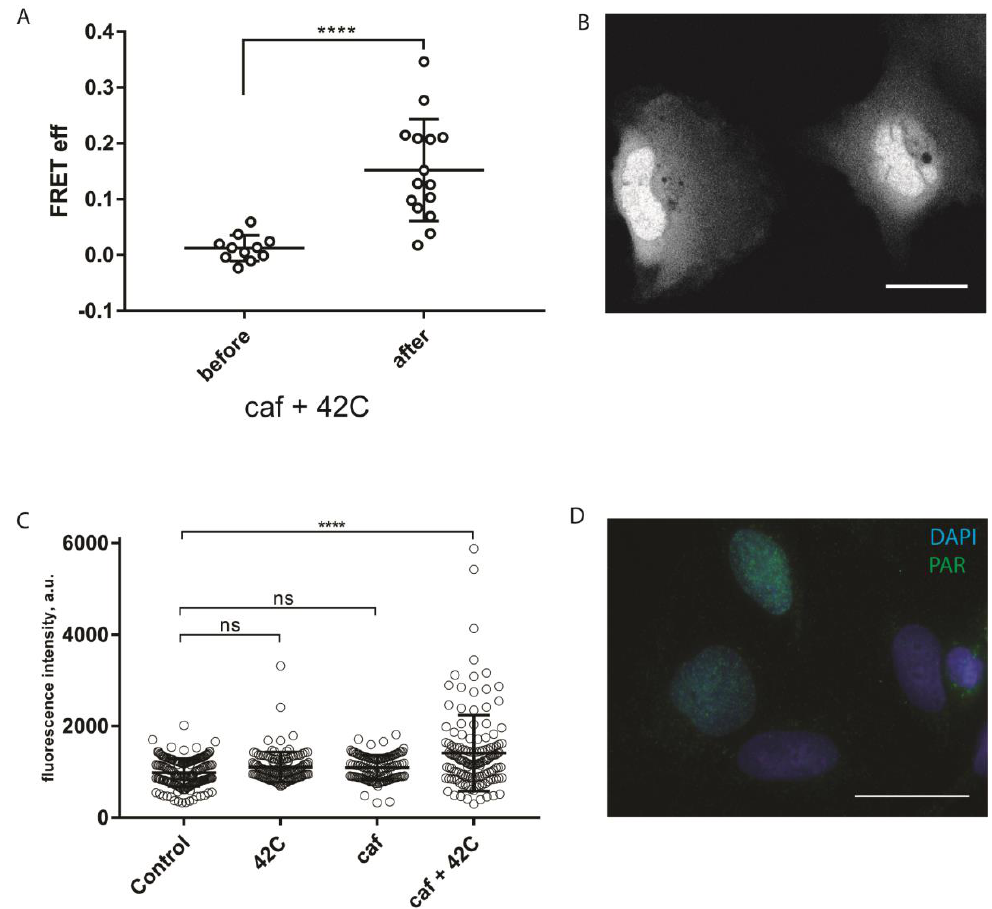
Figure 4. PAR accumulation after ca ff eine and heat shock treatment can be monitored with sPARroW. ( A ) FRET e ffi ciency increases in U2OS cells expressing sPARroW after ca ff eine treatment followed by 30 min heat shock at 42 ◦ C. At least 10 cells were analyzed per experiment. Scale bar 25 µ m. ( B ) Nuclear accumulation of the fluorescence signal from sPARroW after ca ff eine / heat shock treatment. ( C ) Immunofluorescence analysis for PAR accumulation, U2OS cells treated with ca ff eine, heat shock, and both stimuli. ( D ) Confocal microphotograph of ca ff eine / heat shock treated cells stained with DAPI (blue) and anti-PAR antibodies (green). Scale bar 25 µ m. ( A , C )—Mean values ± SD are depicted. Statistical significance was assessed with a one-way-ANOVA and Tukey posttest. The level of significance is given with ns = not significant, **** p < 0.0001